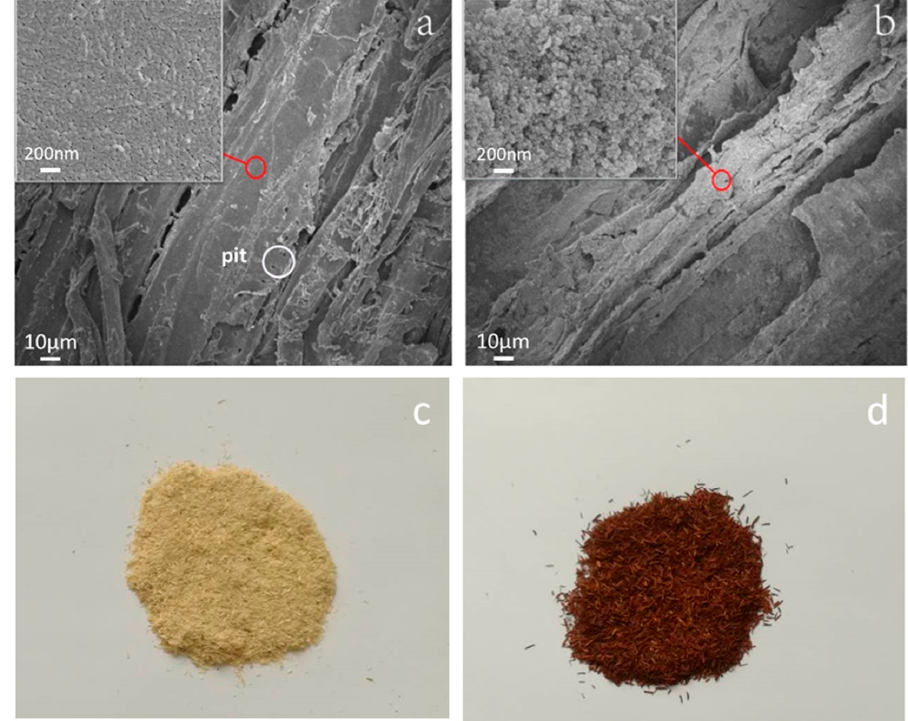
Figure 1. SEM images of untreated wood flour ( a ); magnetic wood flour ( b ); and the photos of untreated wood flour ( c ); magnetic wood flour ( d ).